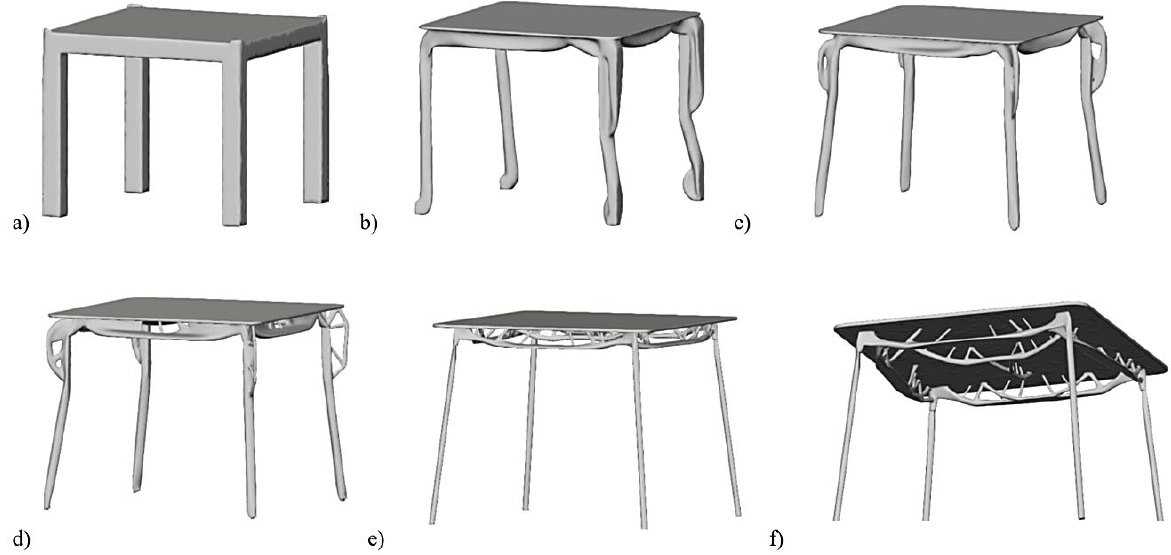
Figure 11. Material distribution changed. The algorithm starts from the initial model geometry (a) after 42 iterations the model_2 get the final optimized geometry (f), the intermediate model shapes are shown from (b) to